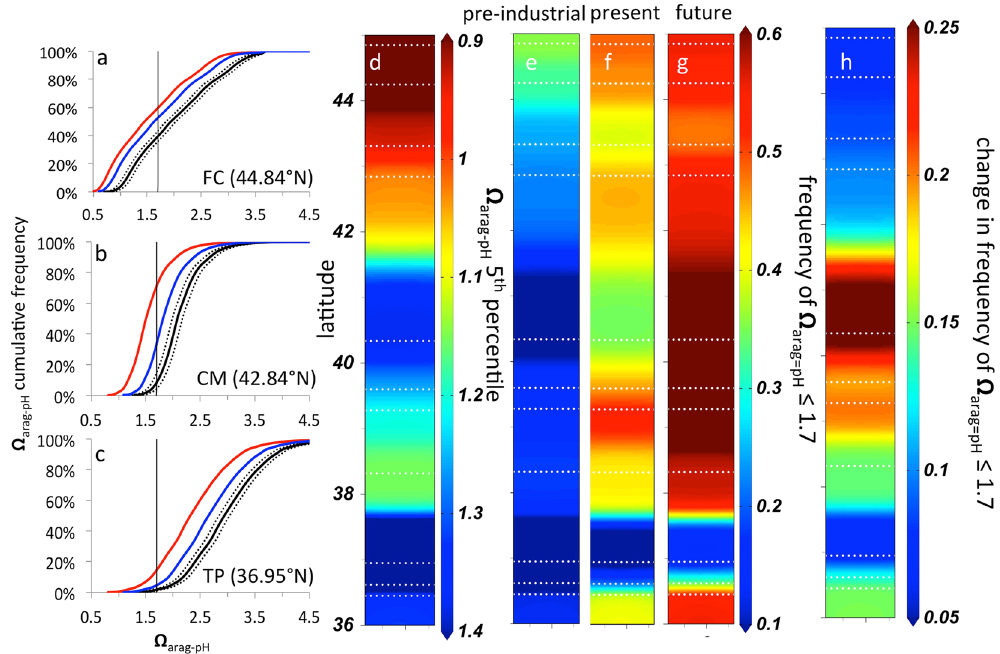
Figure 5. Changes in cumulative frequency of low aragonite saturation state events for three example sites ( a – c ) FC = Fogarty Creek, CM = Cape Mendocino, TP = Terrace Point) from pre-industrial (black), to present observations (blue), to future conditions (red). Black dotted lines represent ± 3 s.d. window for estimates of pre- industrial states. Future conditions reflect the mean of an additional 22 μ mol kg − 1 of DIC that accompanies the arrival of water equilibrated with present-day 400 ppm atmosphere to the CCLME. Vertical lines in ( a–c ) denote Ω arag values of 1.7. Latitudinal patterns are shown for current lower 5 th percentile Ω arag-pH ( d ), and projected past ( e ) present ( f ) and projected future ( g ) frequencies of Ω arag-pH ≤ 1.7, and frequency changes in Ω arag-pH ≤ 1.7 between the present and future projections ( h